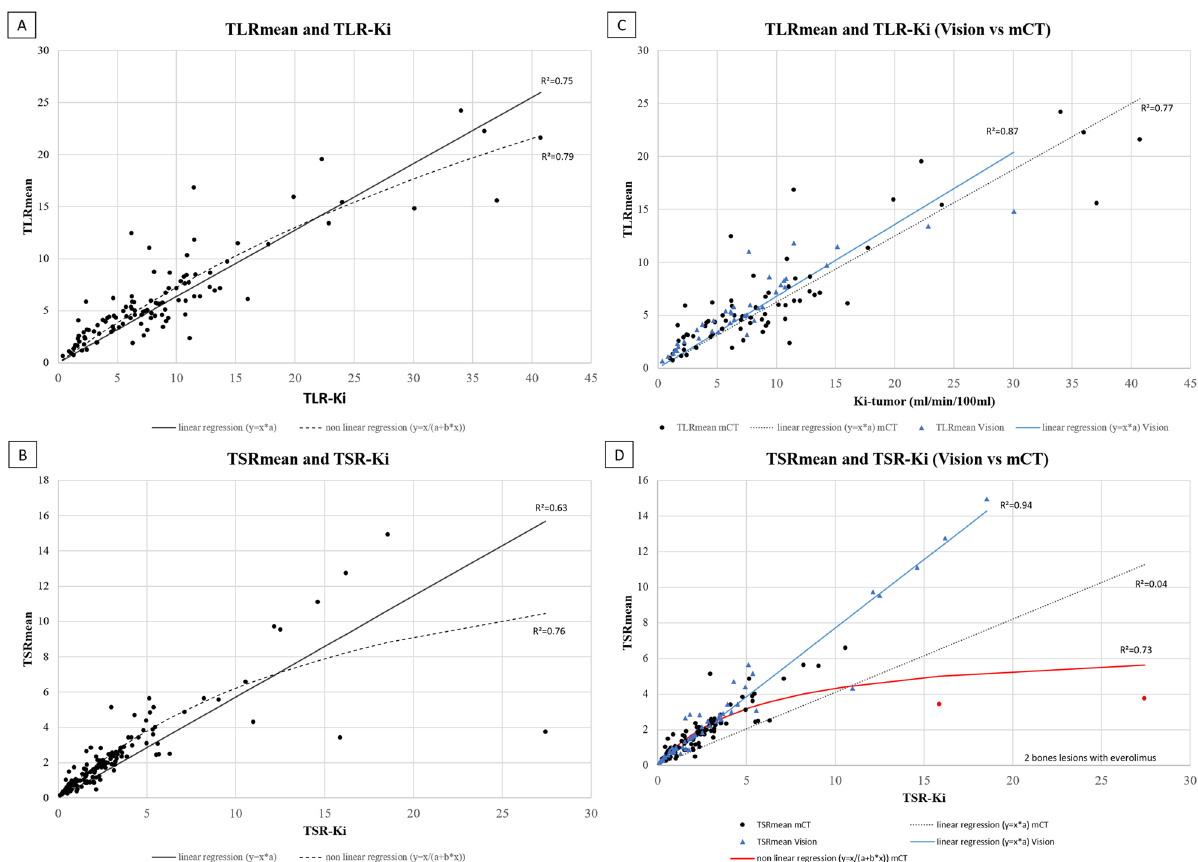
Figure 5. Correlation between TLRmean/TLR-Ki and TSRmean/TSR-Ki in the whole cohort and according to PET system. *Red circle correspond to the 2 bones lesions of patient